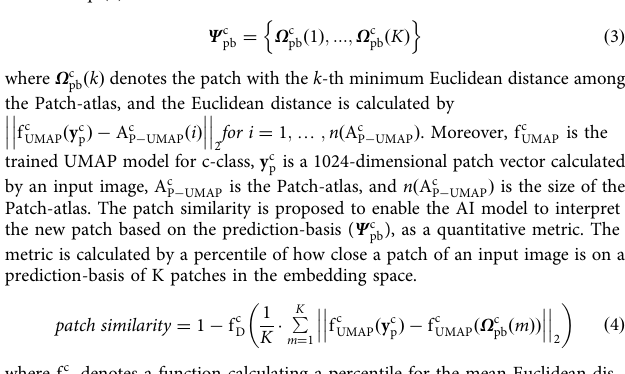
denotes a matrix with the component of u i ; j ¼ u ð CAM c s ð i ; j Þ (cid:1) τ Þ to determine CAM values less than τ as noise components and to remove them. u is a unit step To create the patch atlas, we search for main contours on a high-resolution CAM (512×512) generated from a CAM for each class, select a bounding box to include the outline, de fi ne it as the patch, and save it (one or two patches from a CAM are considered in this study). For each clinical output label, patches are saved as typical, representative patterns from only the CXR images with the AI model ’ s predicted probability of being greater than or equal to 0.9. We train a cosine metric-based UMAP model using the patches for all clinical output labels 24 . The UMAP model transforms the patches into coordinates in two-dimensional embedding space, such that the smaller